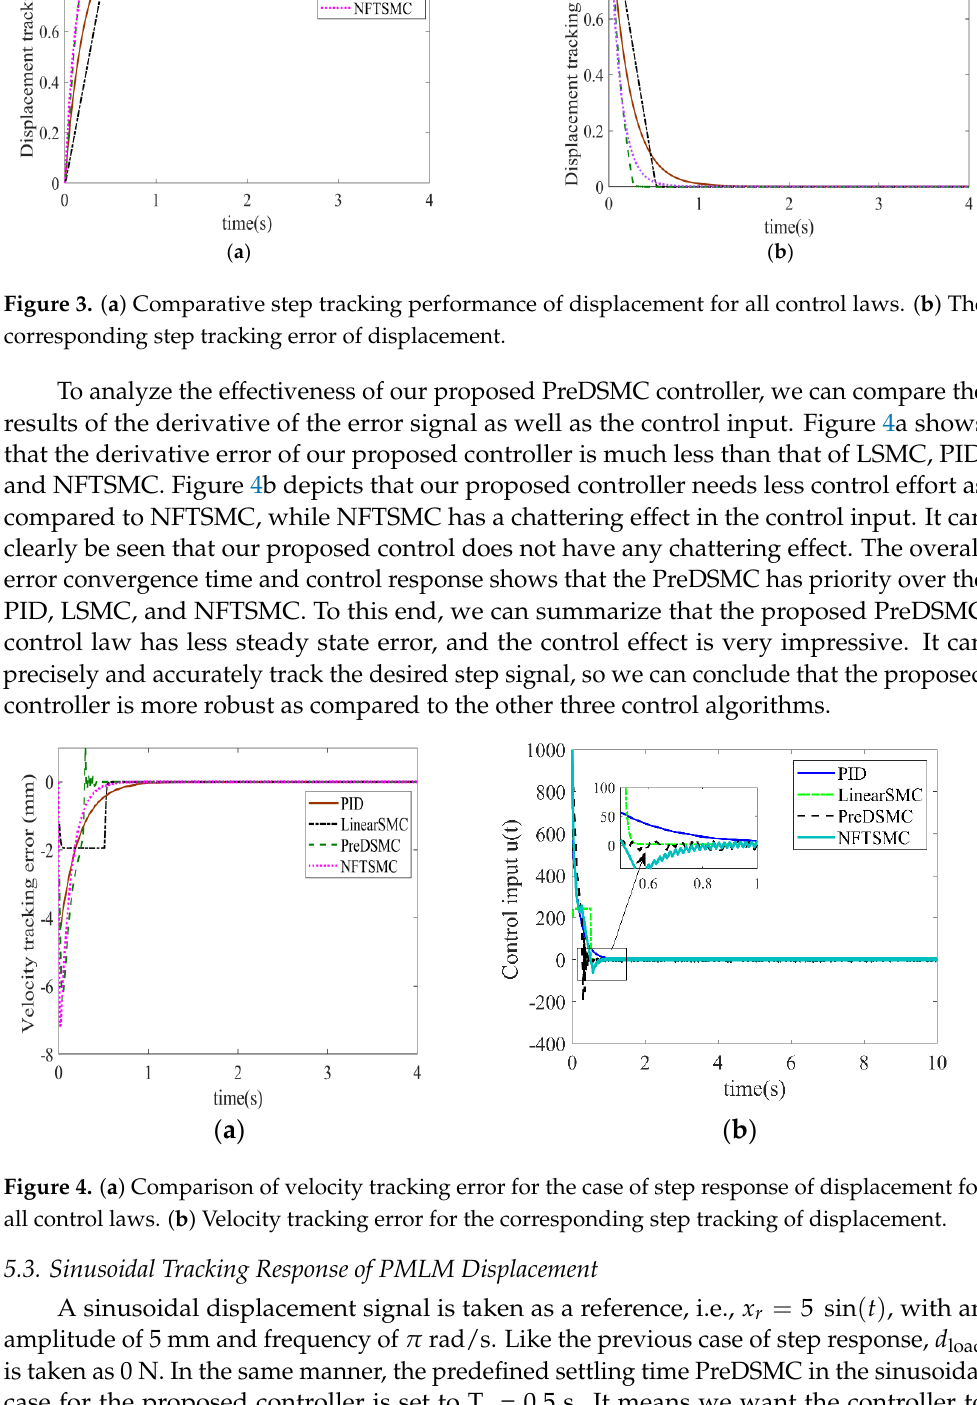
( b ) Figure 5. ( a ) Sinusoidal tracking performance of displacement for all control laws. ( b ) The compar- ison of sinusoidal tracking error of displacement.